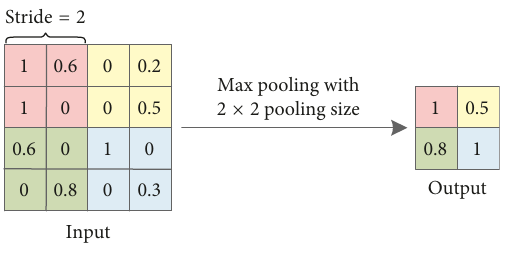
Figure 4: Max pooling process.